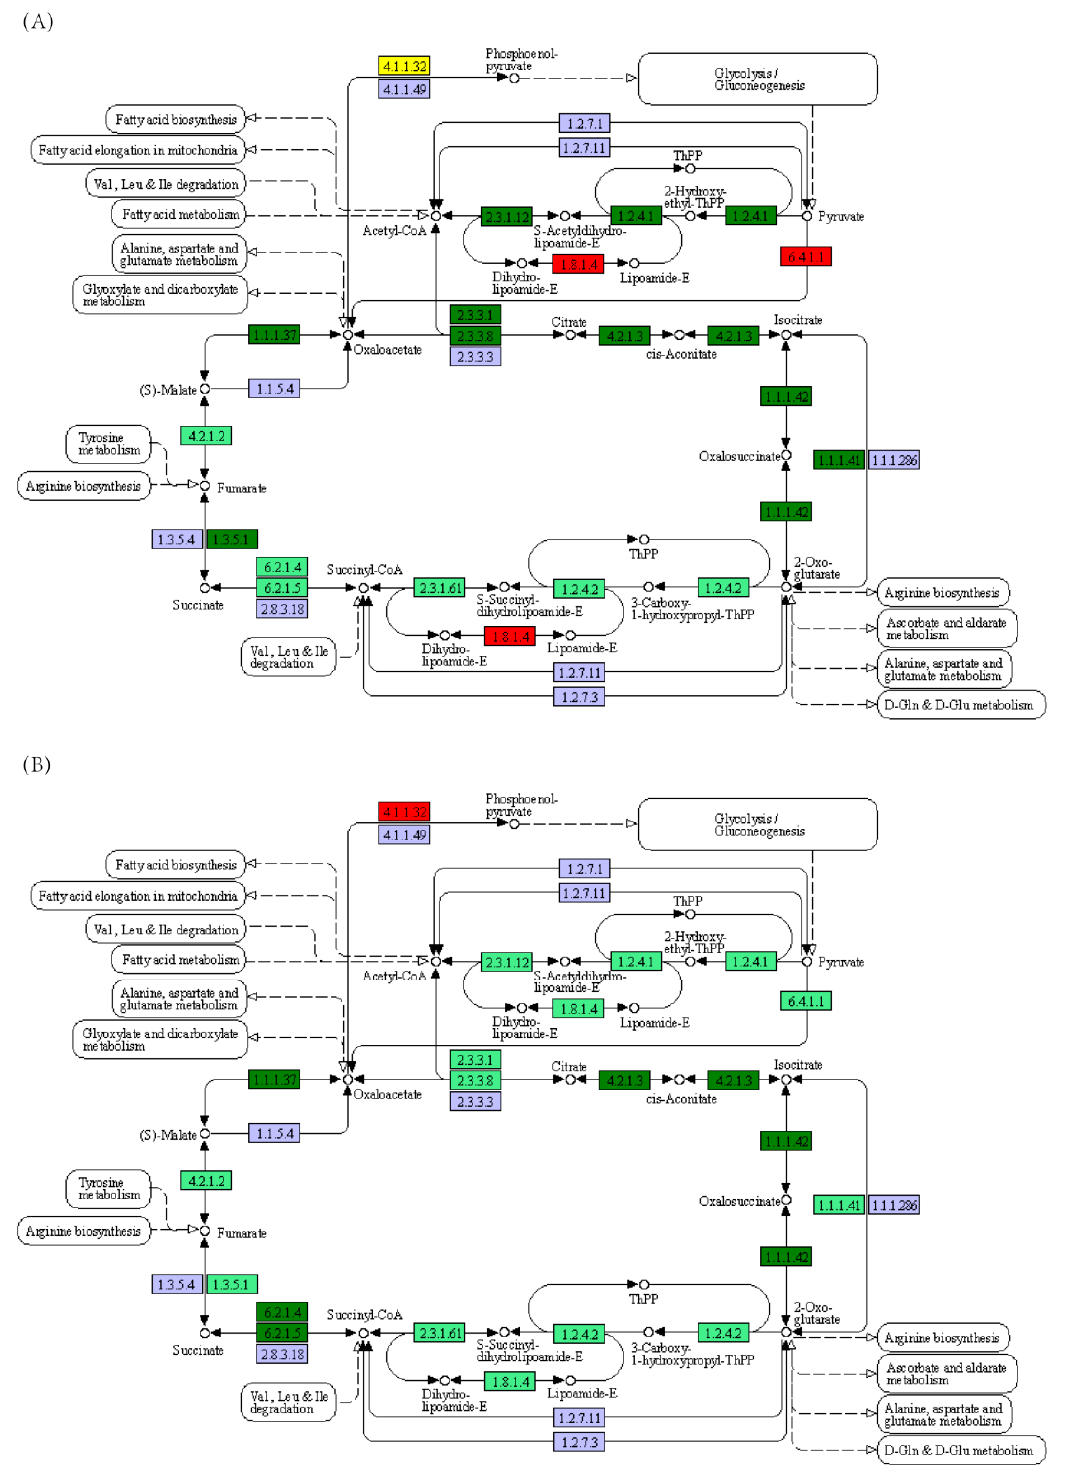
Figure 7. Kyoto Encyclopedia of Genes and Genomes pathway showing the significantly upregulated and downregulated genes involved in citrate cycle (TCA cycle) in the liver transcriptome of yellowcheek starved for ( A ) 8 and ( B ) 28 d compared to the control groups at the same time. Red, dark green, yellow, light green, and light purple indicate significantly upregulated genes, downregulated genes, and both upregulated and downregulated genes in the corresponding genes, the genes of the species annotated on the map, and the genes that were not annotated on the map,